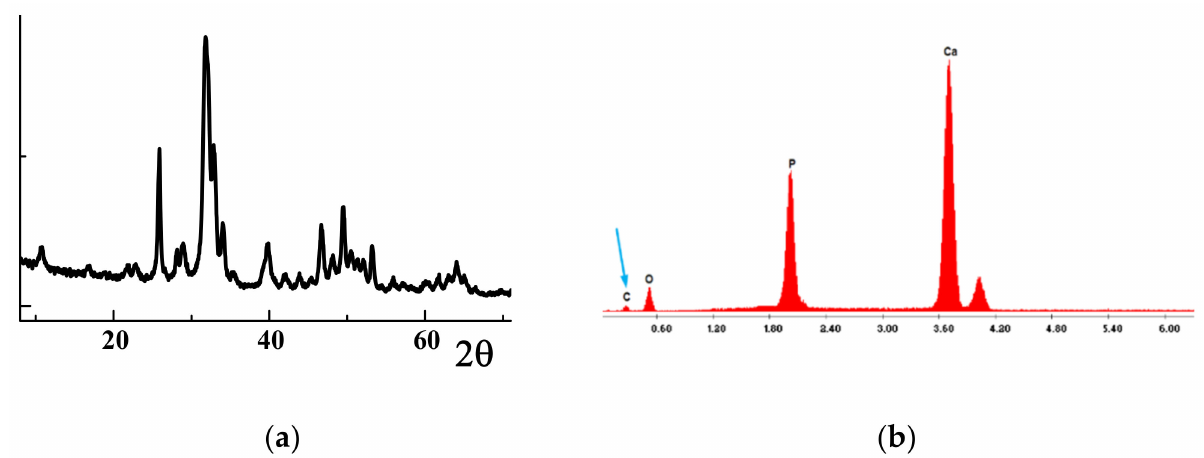
Figure 2. Characterization of C-HAP material: ( a ) XRD patterns, ( b ) EDAX spectra. The C-HAP material, according to the SEM micrographs (Figure 3), consisted of 25 × 100 nm nanorods. The primary nanocrystals were packed in aggregates, leaving small (between nanocrystals) and large (between aggregates) voids that determined the porous structure of the material.